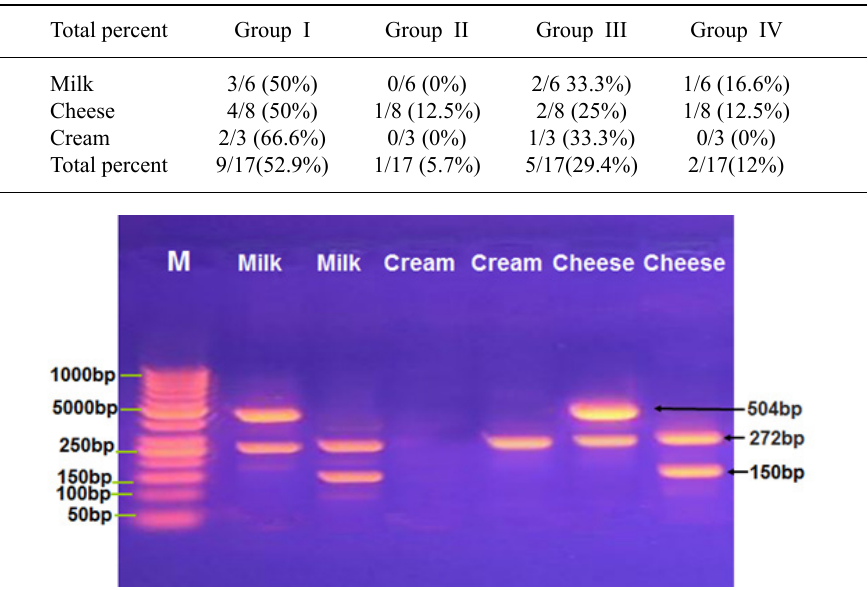
table 1. Shows the groups of the isolates based on the agr system genotyping